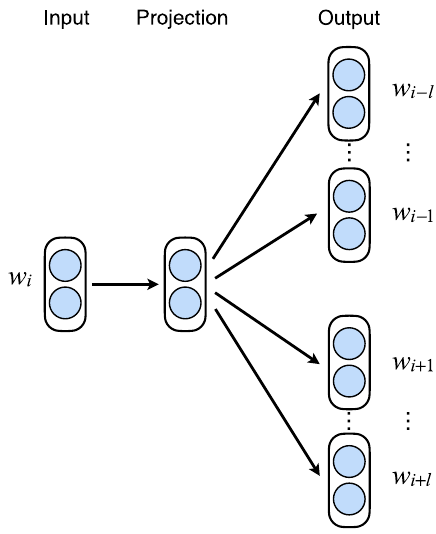
Fig. 10 Architecture of Skip-Gram